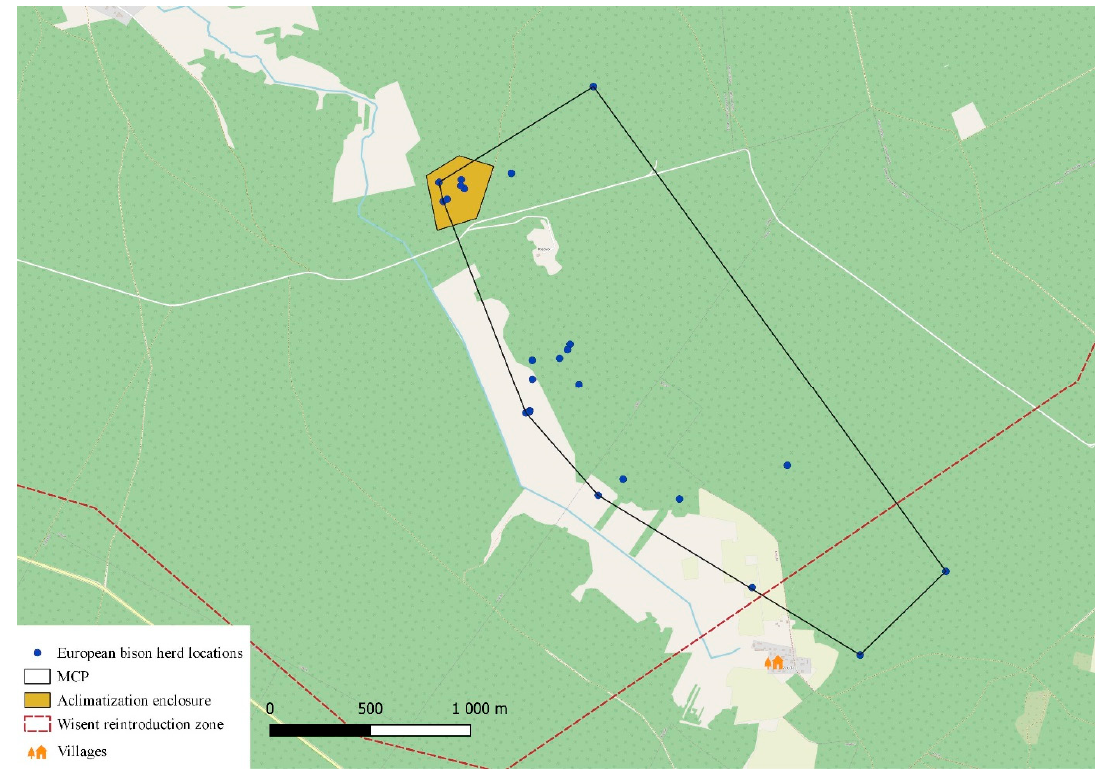
Figure 2. The activity of the European bison in the first 24 h after leaving the enclosure.